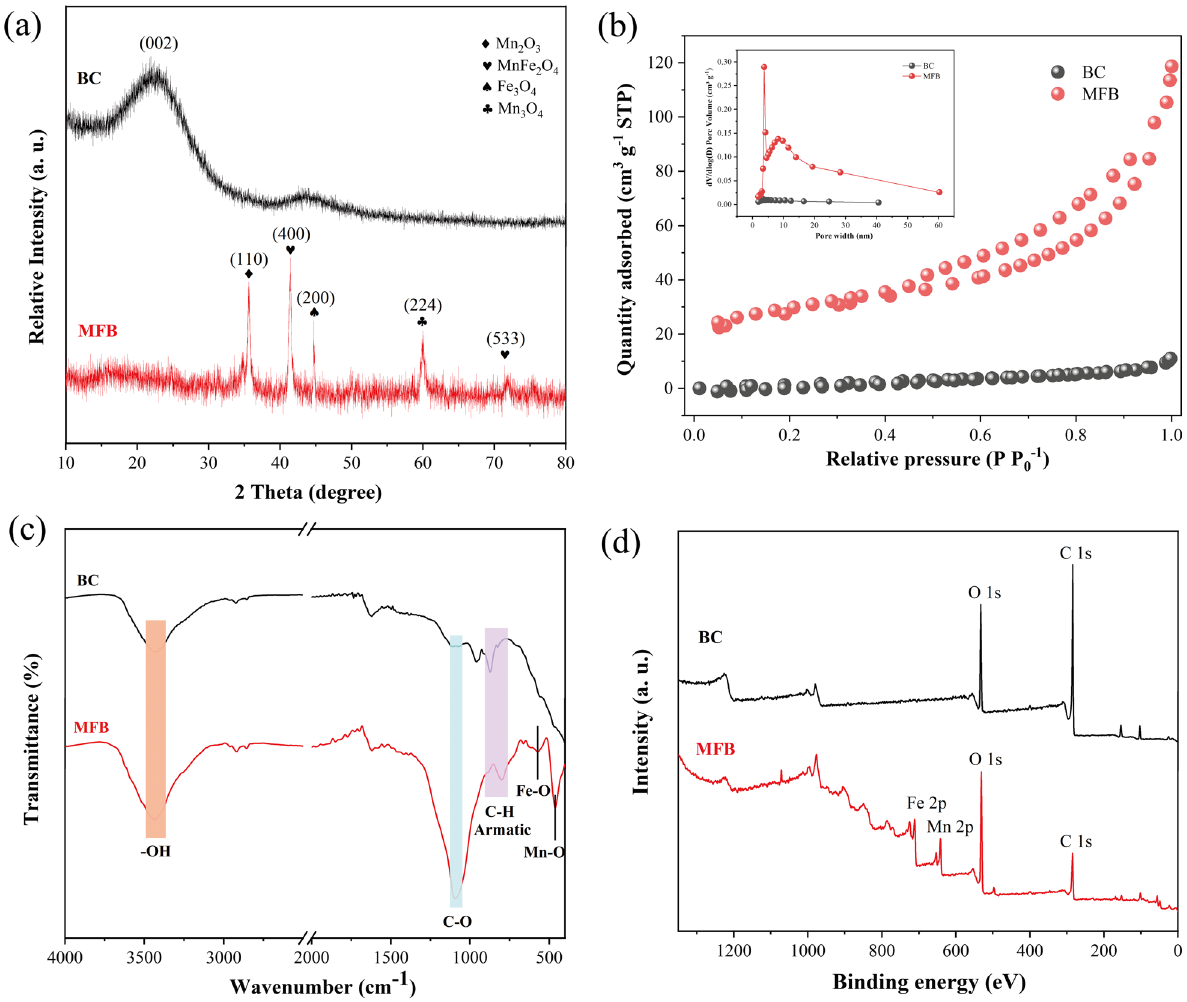
Fig. 2 XRD patterns of BC and MFB ( a ), N 2 sorption isotherms of BC and MFB, insert was the corresponding pore size distribution of BC and MFB ( b ), FTIR spectra of BC and MFB ( c ), XPS spectra of BC and MFB ( d